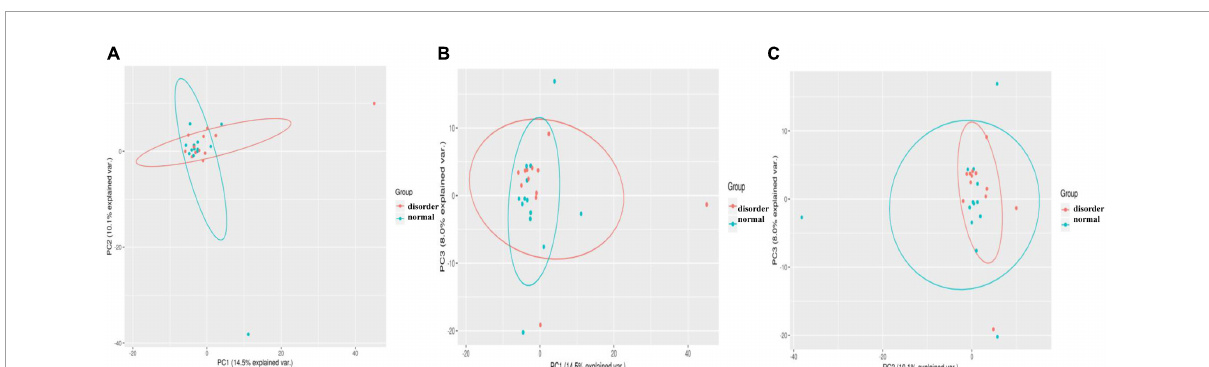
FIGURE3 Samples from different environments may show dispersion and aggregation distribution, and the three components with the highest degree of explanation for sample differences in PCA results can be used to verify hypothetical factors. PC1 (A) , PC2 (B) , and PC3 (C) represent the suspected influencing factors of microbial composition deviation between sleep disorder group and normal sleep group, respectively, indicating that there are significant differences in microflora between sleep disorder group and normal sleep group after